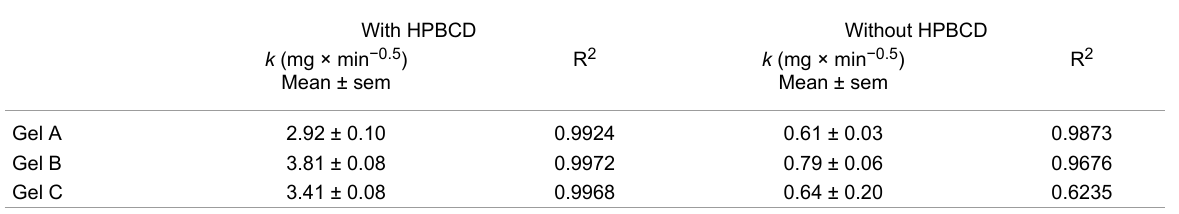
Table 2: Fitting results yielding the quantity of fluconazole release up to 120 min using the Higuchi release kinetics. a